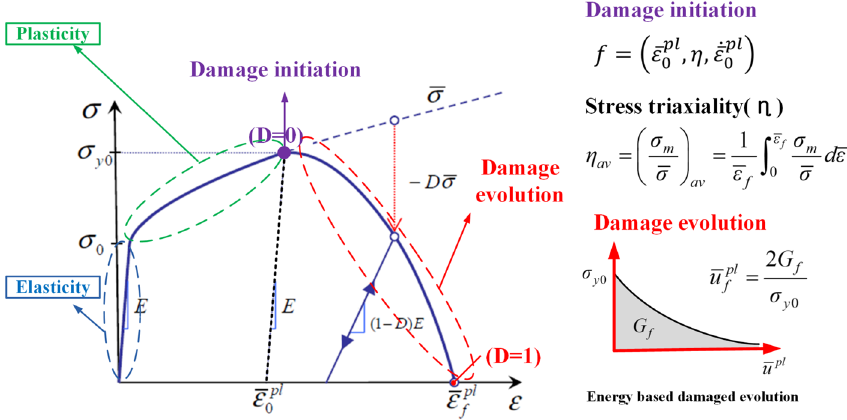
Figure 2. Schematic illustration of elastic–plastic material with progressive damage.